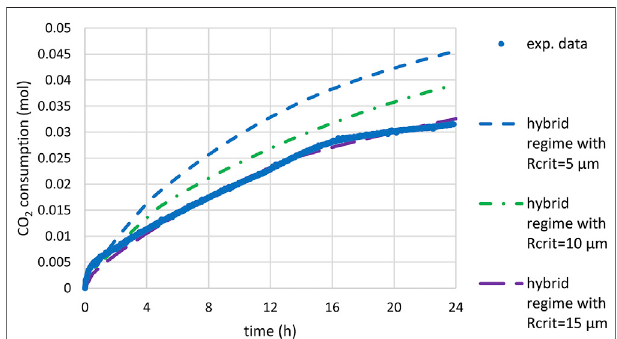
FIGURE 13 | Time-CO 2 consumption during slag carbonation (T (cid:2) 180 ° C, P CO2 (cid:2) 20 bar) under attrition with sand quartz: comparison of experimental data and prediction of the mixed model (starting under kinetic control and ending under diffusion control below a given critical radius R crit ): calculations using the PSD of feed material, k ref multiplied by a factor 5 and D eH + equal to 1.3 × 10 – 11 m 2 s − 1 .